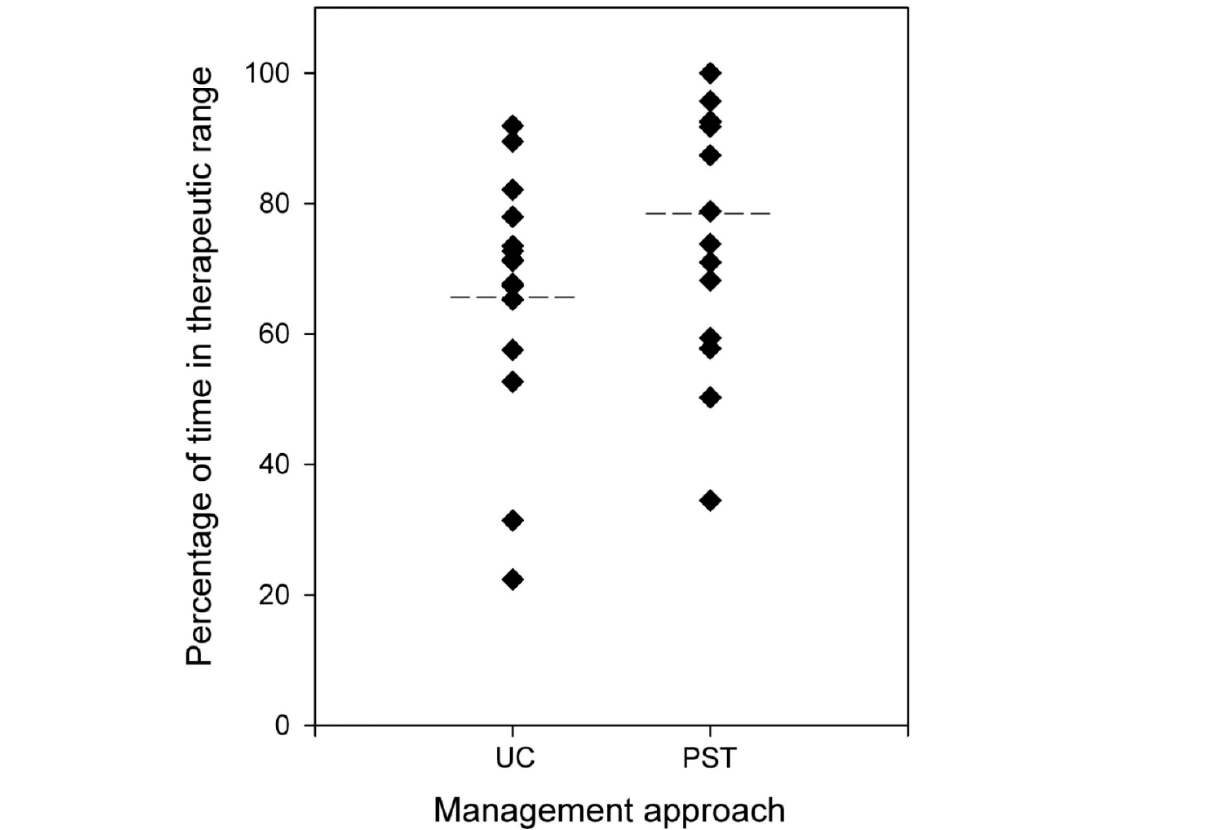
Figure 2. Individual percentage of time in therapeutic range (TTR) during patient self-testing (PST) and usual care (UC) (the dotted line shows the mean TTR for each management